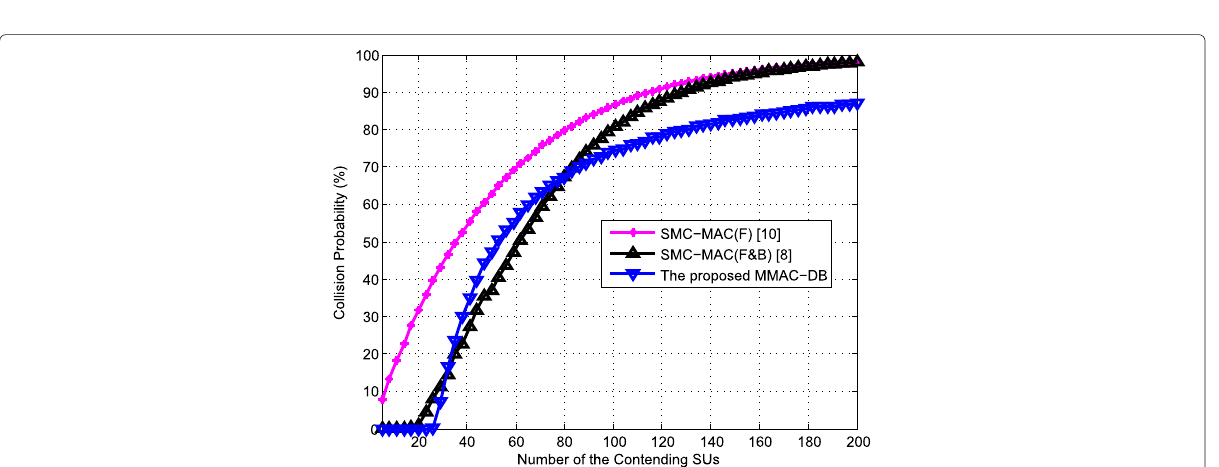
Fig. 5 Collision probability. Collision probability is an important metric to evaluate the control channel bottleneck